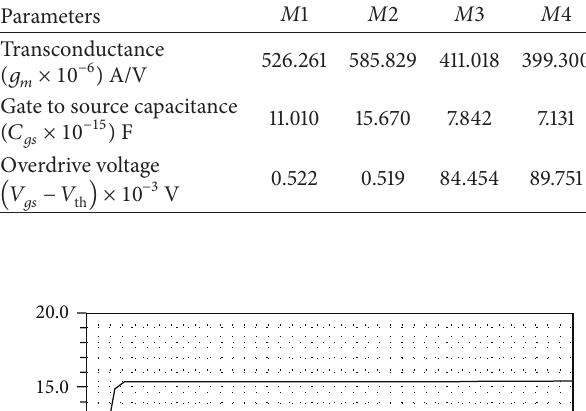
Figure 11: Frequency responses of the conventional and proposed current mirrors (where CM refers to current